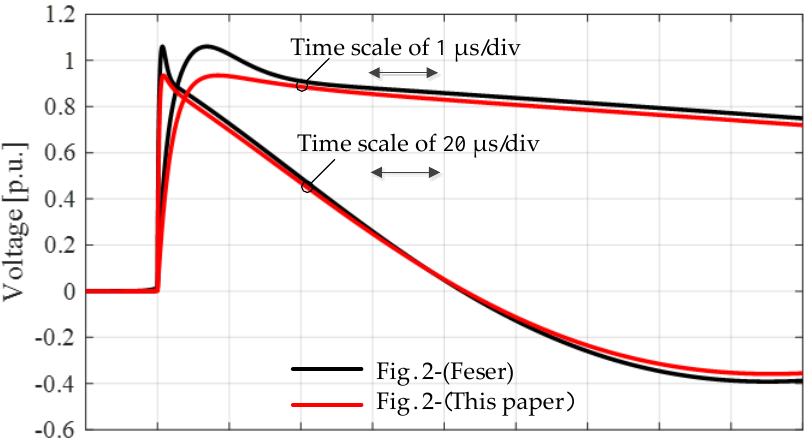
Figure 4. Comparison of generated waveforms by Glaninger’s circuits.